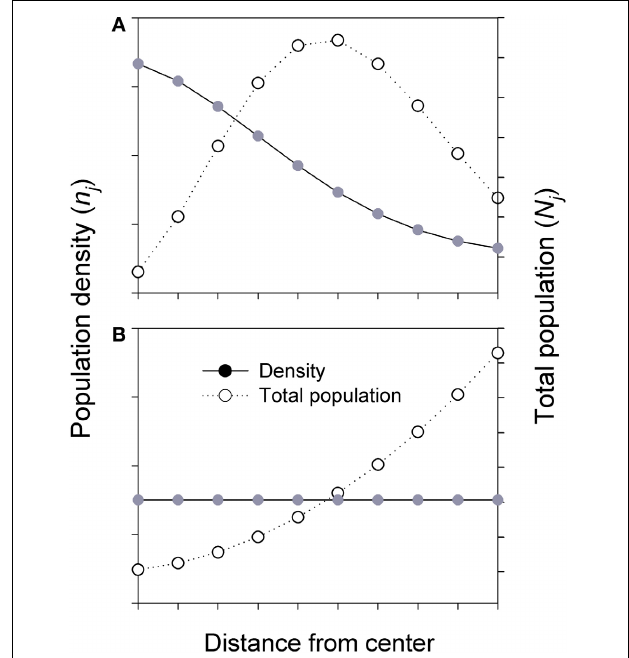
FIGURE 3 | Simplified diagrams showing the population density ( n ) and total population size ( N ) in each ring (i.e., sum of all populations) across the whole species range or a patch (i.e., from center to margin). N j = n j A j ; where A j and n j are the area and population density in j th ring, respectively. (A) Total population (all populations in each ring) is estimated based on Gaussian-like distribution of population density across the species range or a patch. (B) Total population is estimated based on uniform or random of population density across the species range or a